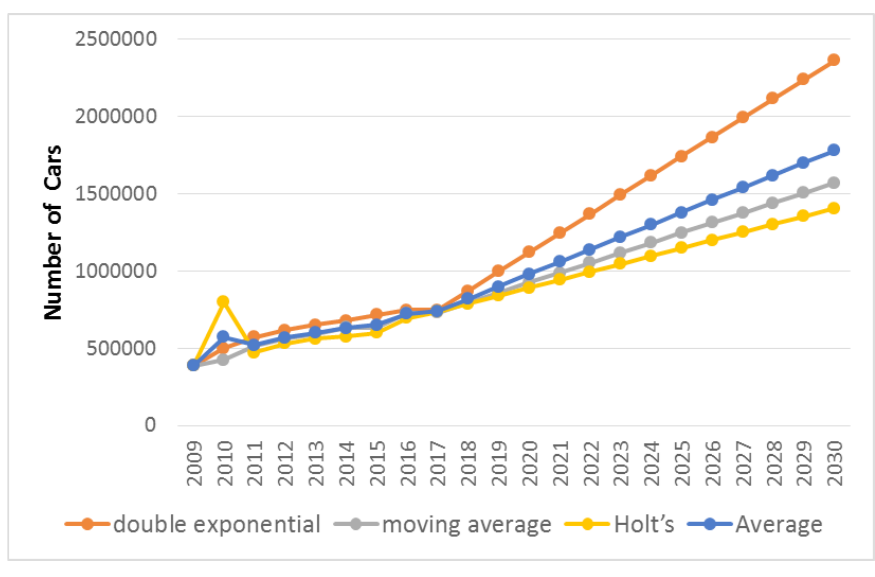
Figure 3(a): Car stock prediction.